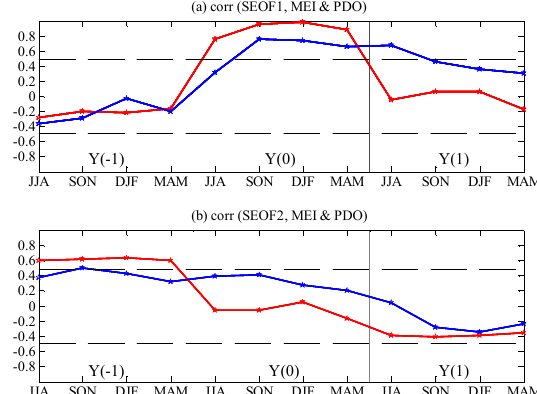
Figure 5. ( a ) Lead–lag correlations between the first SEOF PC and the MEI (red line) and PDO index (blue line); ( b ) As in ( a ), but for the second mode. The dashed lines indicate at the 5% significance level of the Student’s t -test. Year( − 1) (Year(1)) denotes that the PC lags behind (leads) its counterpart by one year; Year(0) denotes simultaneous correlation. JJA is boreal summer, SON is boreal autumn, DJF is boreal winter, and MAM is boreal spring.